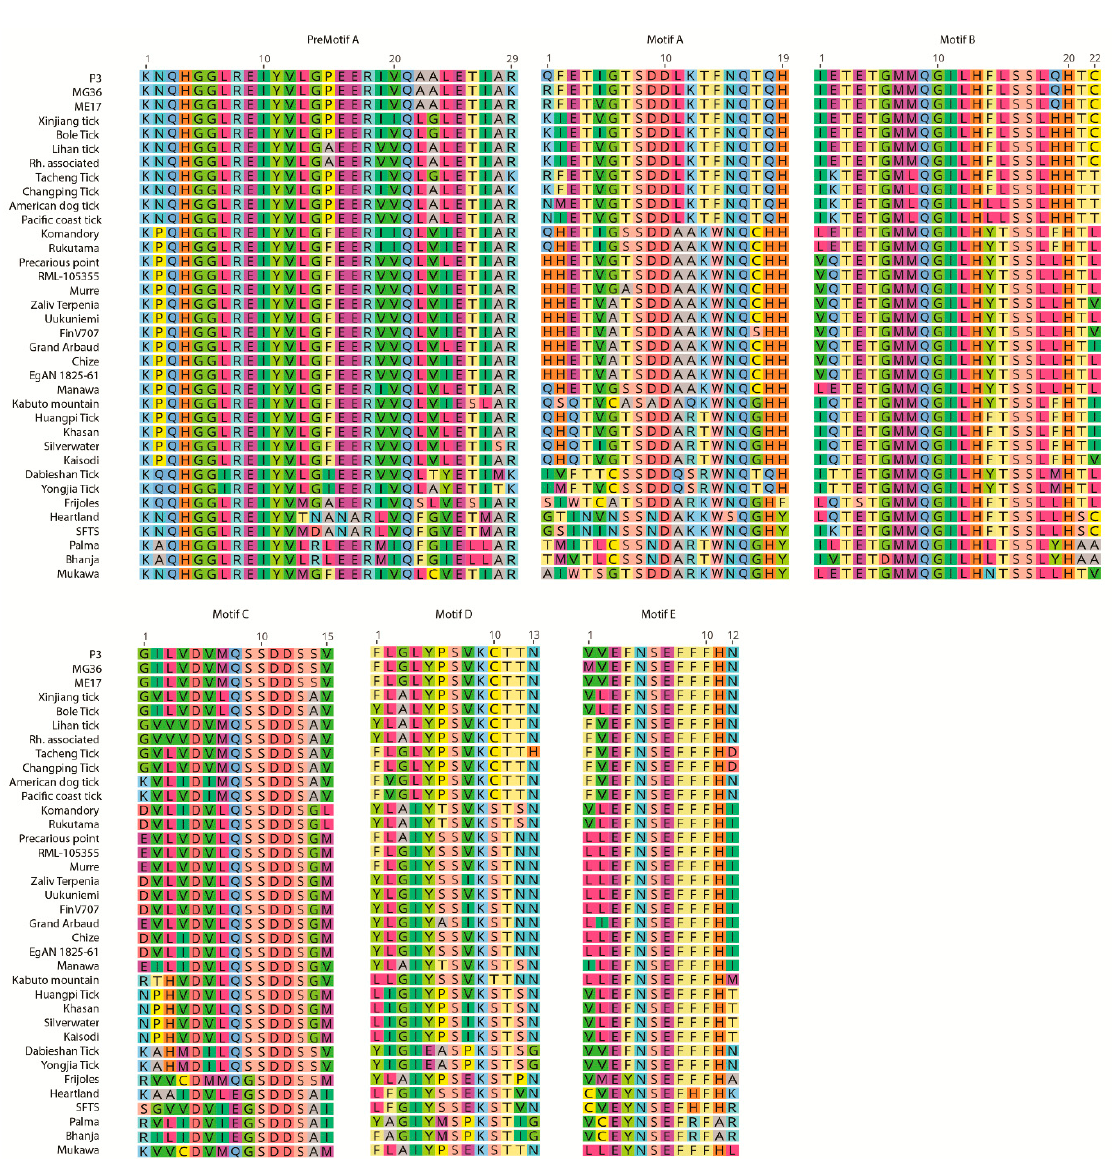
Figure 5. Alignment of the phlebovirus RNA-dependent RNA polymerase conserved motifs, as located on the amino acid residues 936–970 (premotif A), 1008–1026 (motif A), 1107–1129 (motif B), 1152–1168 (motif C), and 1197–1223 (motif D / E) positions on the Uukuniemi virus genome L segment